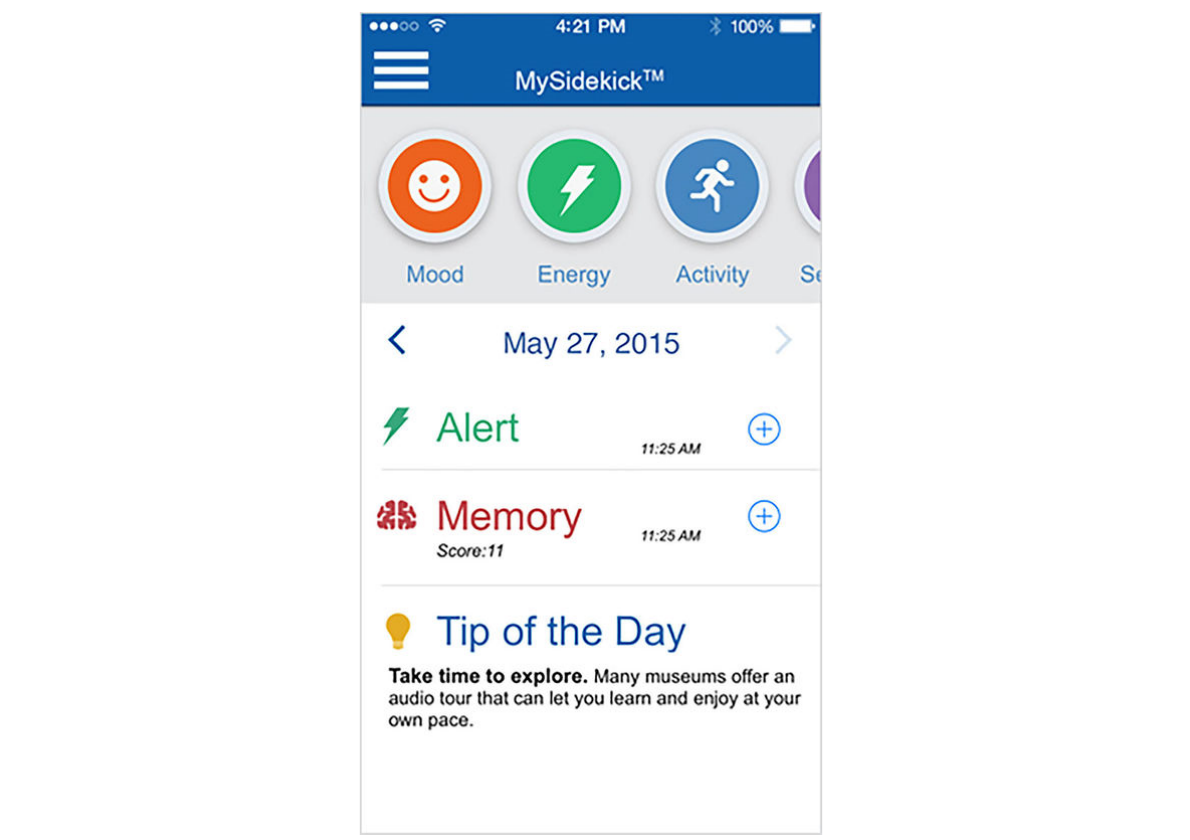
Figure 2. Example of energy and resource management multiple sclerosis